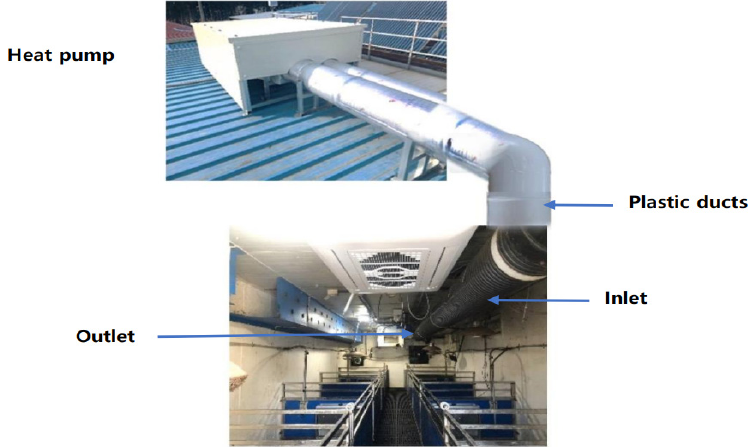
Figure 1. The schematic design of the air heat pump (AHP) cooling system [13].